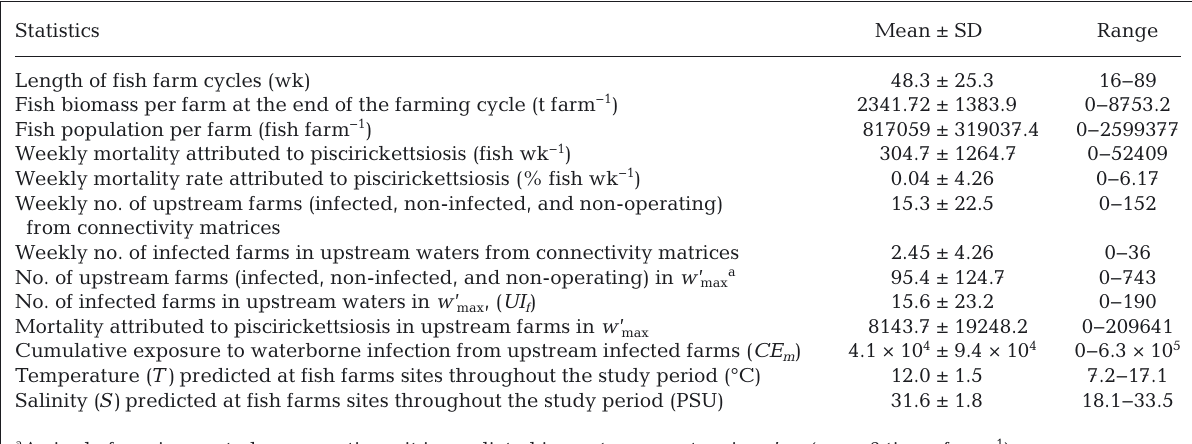
Table 1. Summary statistics of salmon fish farm cycles considered within the study (n = 318) and observed variability in oceanographic conditions. w ’ max : window of